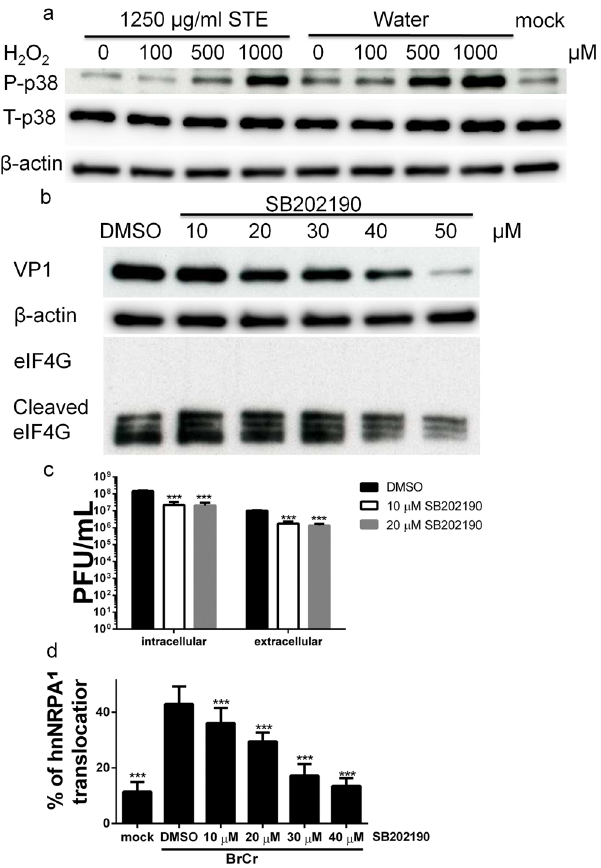
Figure 5. STE inhibits ROS-induced p38 kinase activation that is critical to EV71 infection. ( a ) RD cells were un- or treated with 100, 500 or 1000 μ M H 2 O 2 for 20 min in the absence or presence of 1250 μ g/ml STE. Expression of total and phosphorylated p38 kinase and β -actin was examined by western blotting. The cropped images of the blots are shown. A representative experiment out of three is shown. ( b ) RD cells were pre-treated with DMSO or 10, 20, 30, 40, or 50 µ M SB202190 for 1 h, and infected with BrCr at m. o. i. of 5 for 1 h. The cells were harvested at 9 h p. i. for western blotting with antibodies to VP1, eIF4G and β -actin. The cropped images of the blots are shown. A representative experiment out of three is shown. ( c ) Cells were treated with DMSO or SB202190, and infected as described in ( b ). Intracellular and extracellular progeny virus was collected at 9 h p. i. for titer determination. Data are means ± SD of three separate experiments. *** P < 0.0001, vs. infected cells with DMSO treatment. ( d ) RD cells were transfected with hnRNP A1-GFP. Twenty-four hour later, the transfected cells were pre-treated with DMSO or 10, 20, 30, 40, or 50 µ M SB202190 for 1 h, and infected with BrCr at m. o. i. of 20 for 1 h. The cells were fixed at 6 h p. i., stained with Hoechst 33342, and subject to image analysis using IN Cell Analyzer 1000. The percentage of cells showing cytoplasmic relocation of hnRNP A1 were quantified. Data are means ± SD of three separate experiments. ** P < 0.005; *** P < 0.0001, vs. infected cells with DMSO